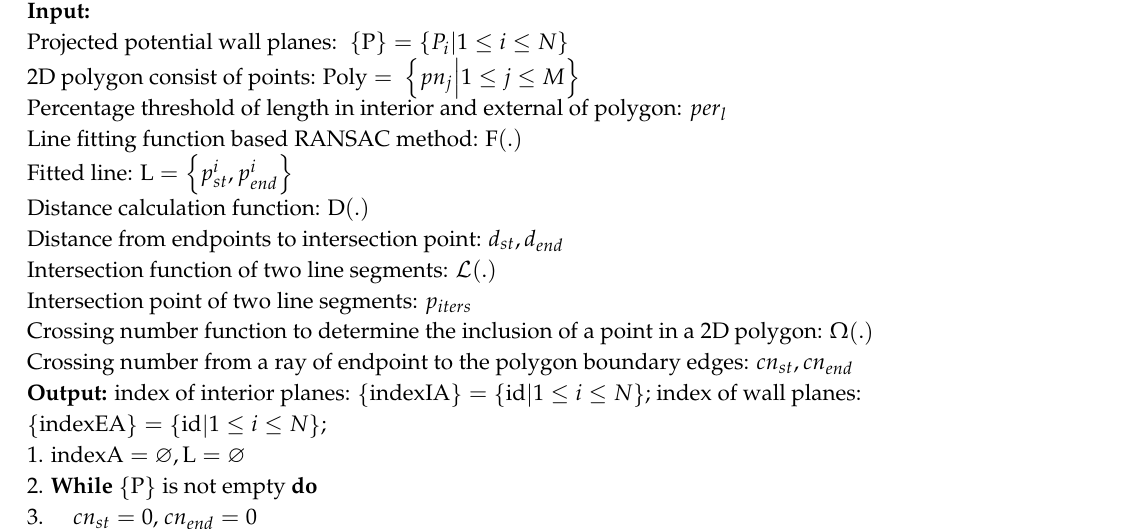
Algorithm 1: Interior elements filtering